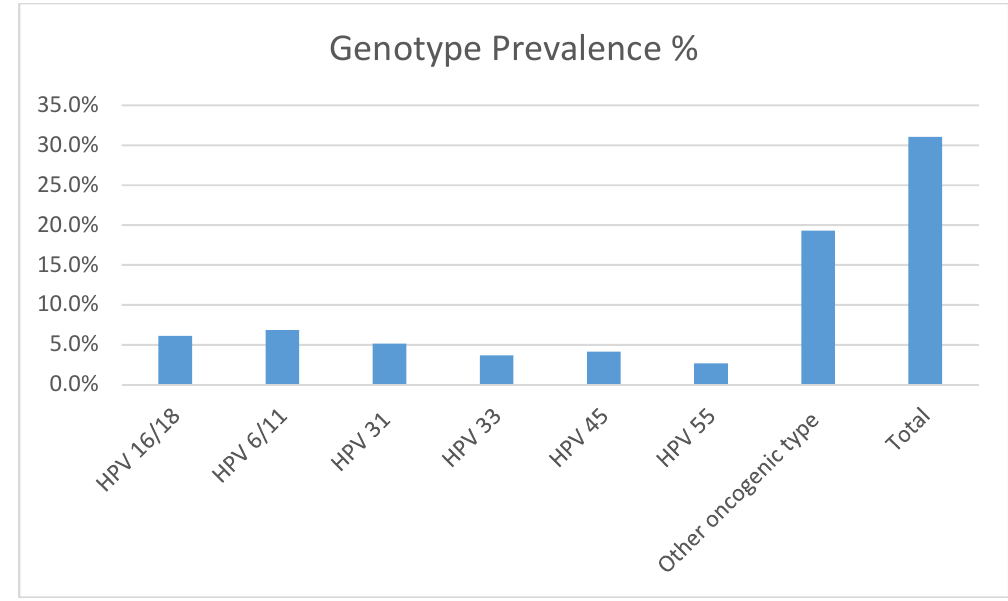
Figure 1. Human papillomavirus (HPV) genotype prevalence and distributions. In the case of multiple genotypes, each genotype was counted independently.